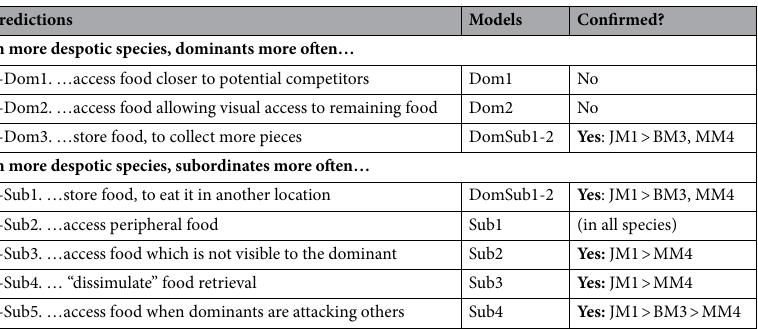
Table 1. Predictions of our study, models used to test them, and whether they were